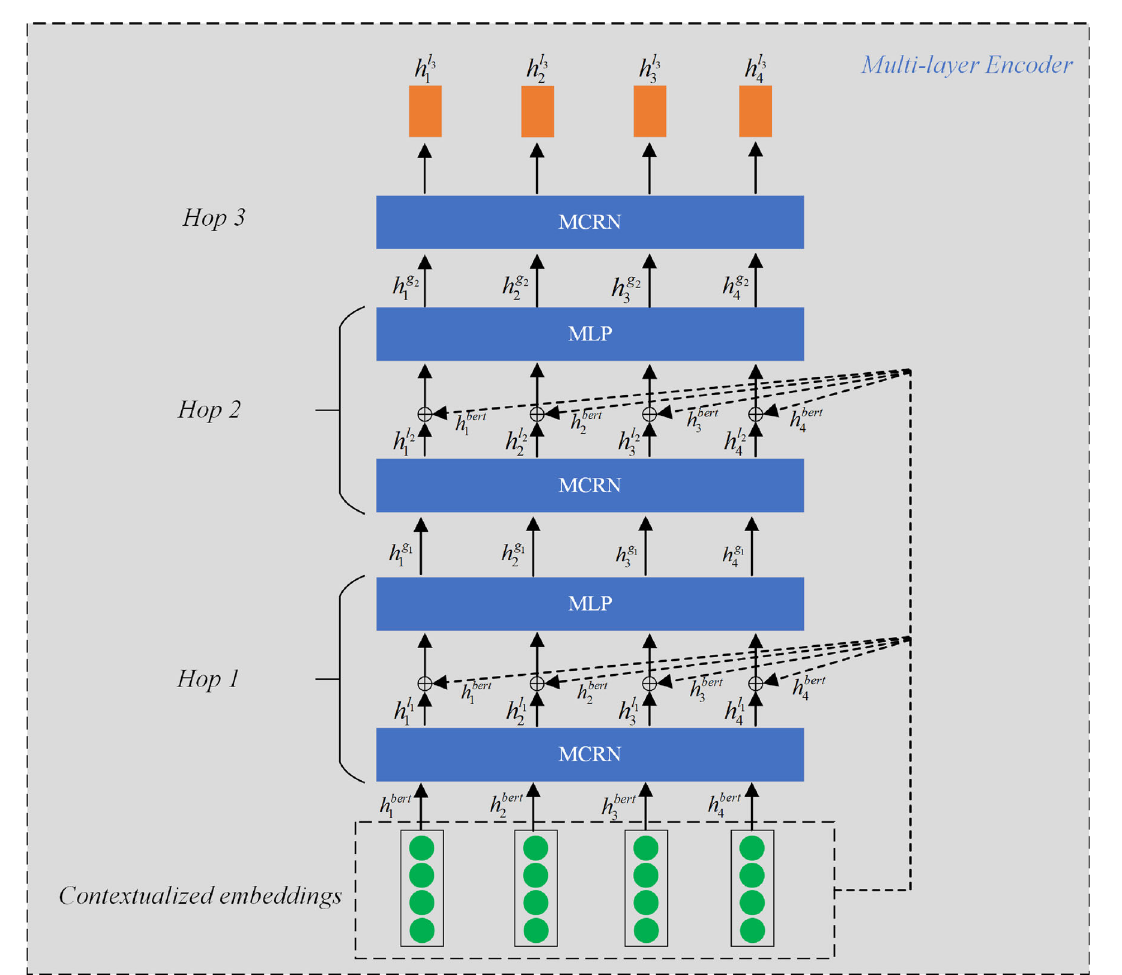
Fig. 4 The overall framework of the multi-layer encoder with three computational layers (hops) in IANN